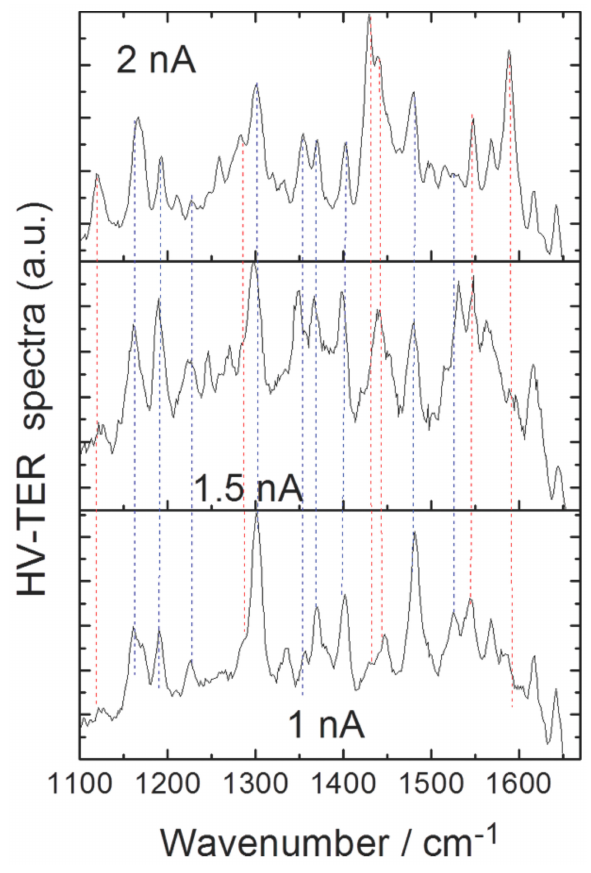
Figure 5. HV-TERS spectra of 2,2’DA-DMAB produced from 2,4-DNBT with different tunneling currents